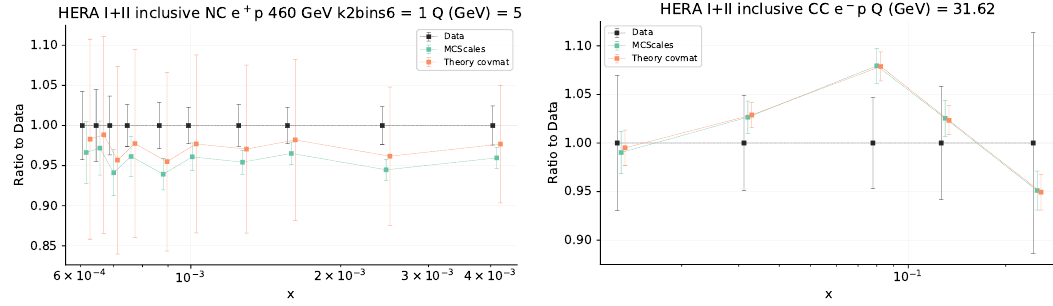
Figure 8 . Ratio to HERA inclusive neutral current positron-electron cross section data [40] (left) and HERA inclusive charged current data [41] (right) of the theoretical predictions obtained with MCscales and theory covariance matrix approaches to the respective